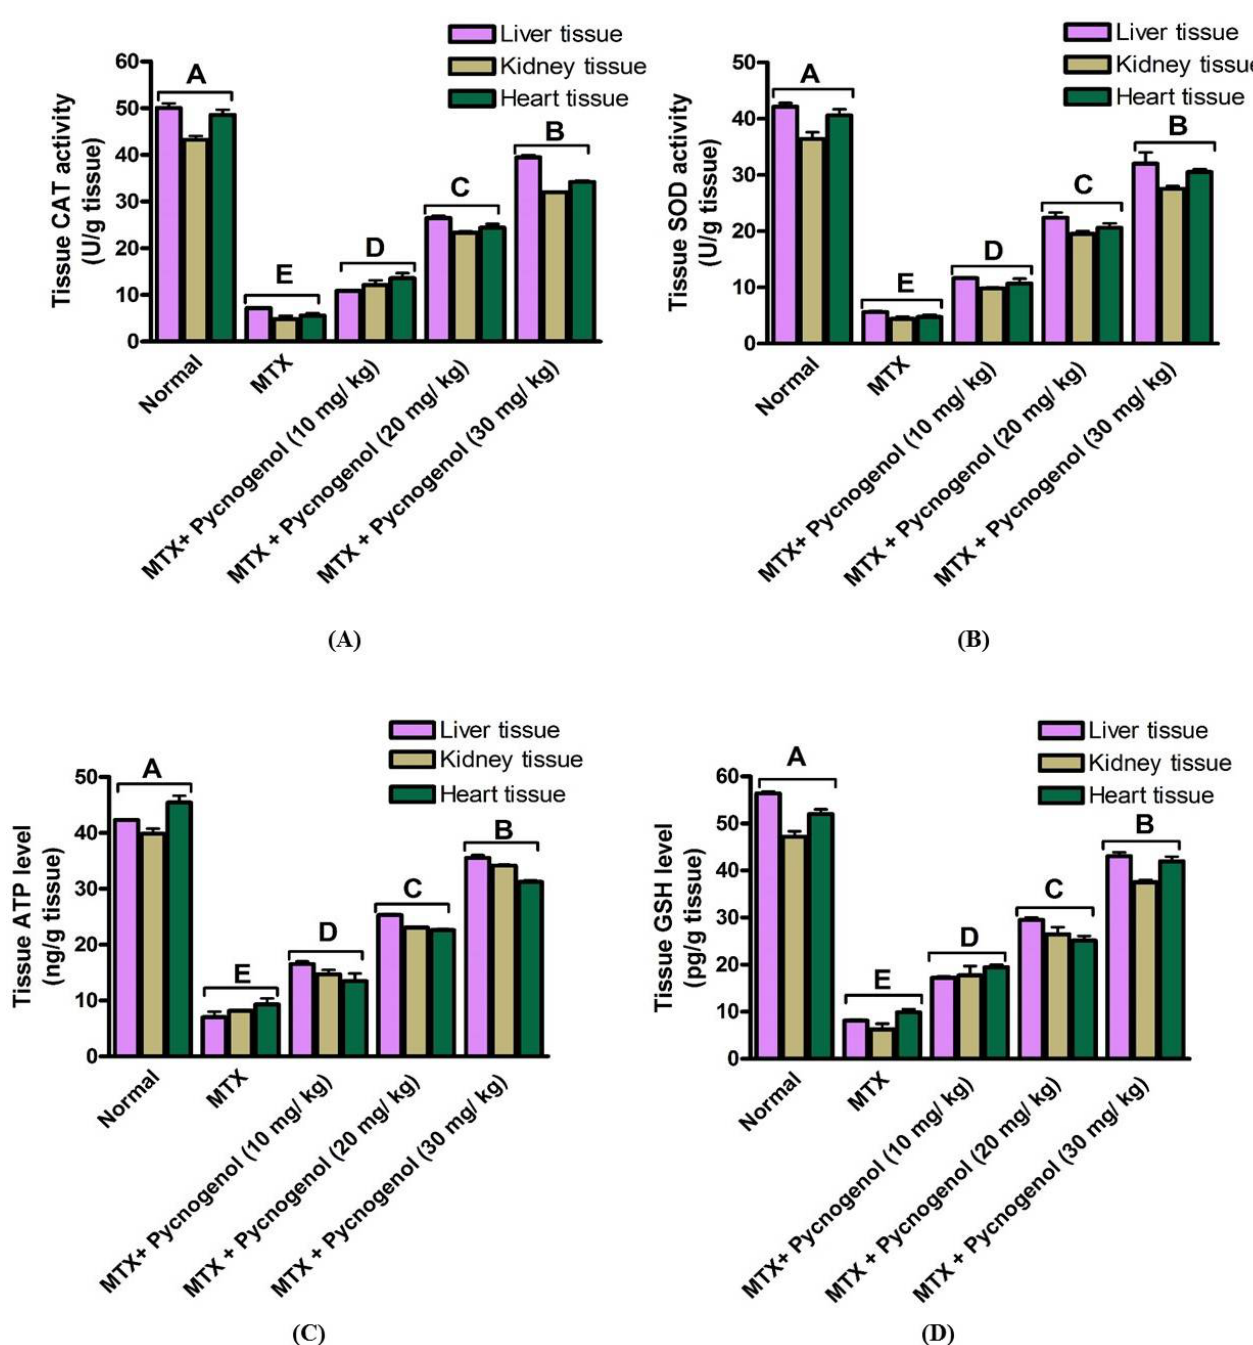
Figure 3. Effect of pycnogenol and/or MTX treatment on ( A ) CAT, ( B ) SOD, ( C ) ATP, and ( D ) GSH oxidative stress biomarkers (mean ± SD) in different organs. Data are mean ± SD of six rats/group. CAT: catalase, SOD: superoxide dismutase, ATP: adenosine triphosphate, GSH: reduced glutathione. p -value < 0.05 is significant. Bars represent the mean value and the standard error for means. Bars with different letters are significantly different according to DMRTs at p = 0.05.